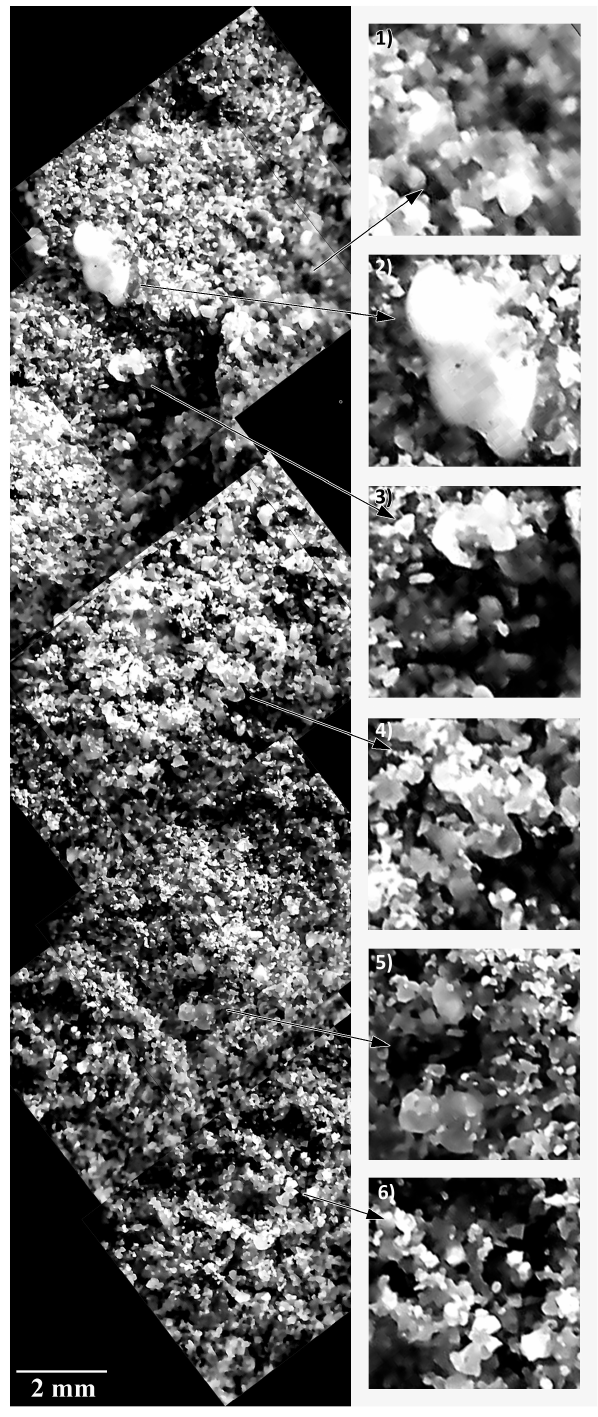
Figure 5. Section of the borehole wall can be seen on the left side, which was recorded from a drilled borehole (0601) in one of the wadi beds (30,984 N; -7,151 E) with grazing light (1*1 mm). Magni- fied insets on the right show interesting parts of the target, the images were recorded in the east asimuthal direction.